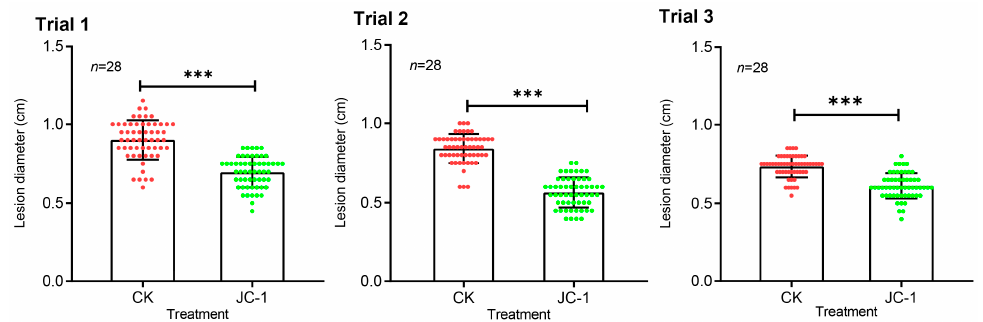
Figure 8. Histograms showing cotyledon lesion diameters on seedlings of oilseed rape treated with water alone (CK) and S. lamellicola (JC-1). The three trials were independently performed. ***, significantly different between CK and JC-1 at p < 0.001 according to a Student’s t test. Table 3. Number and percentages of tissues of oilseed rape (roots, stems and leaves) colonized by S. lamellicola JC-1.